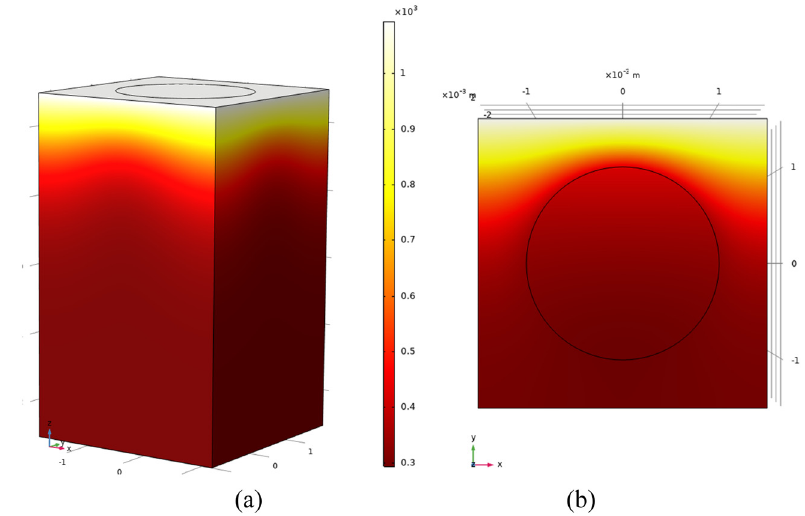
Figure 3: Heat conduction of fi ber bundle: ( a ) longitudinal and ( b ) transverse.